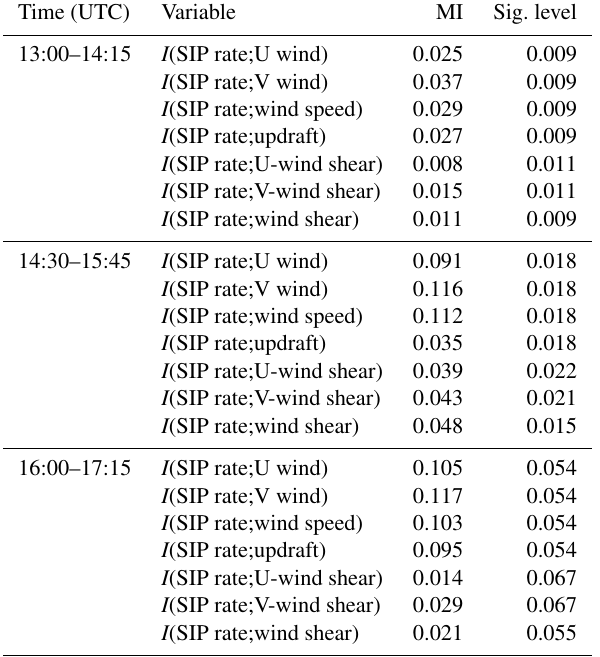
Table 3. Mutual information between SIP rate and wind properties of the vertical profiles for the BR2.8T simulations. The significance level is calculated by taking the maximum of 1000 Monte Carlo simulations of mutual information between a random permutation of SIP rates and each